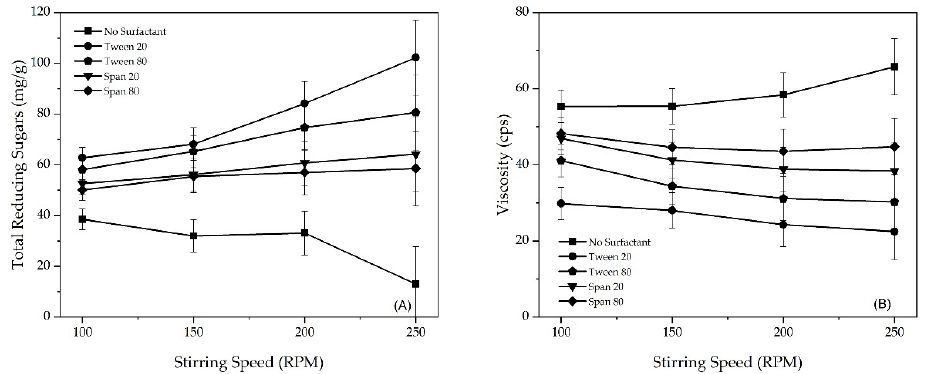
Figure 5. The effects of the stirring speed on the formation of reducing sugars ( A ) and viscosity ( B ) at the various types of surfactant. The reaction time was 24 h.